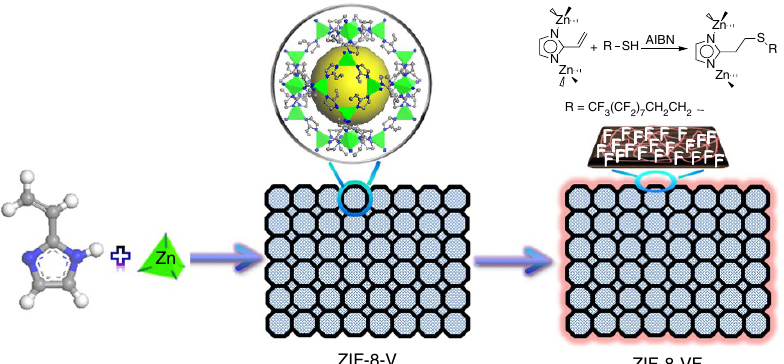
Figure 2 | Schematic illustration to impart amphiphobicity on ZIF-8-V. Synthetic route to create amphiphobic surface via grafting perfluoroalkyl groups on the exterior surface of the ZIF-8-V crystal.